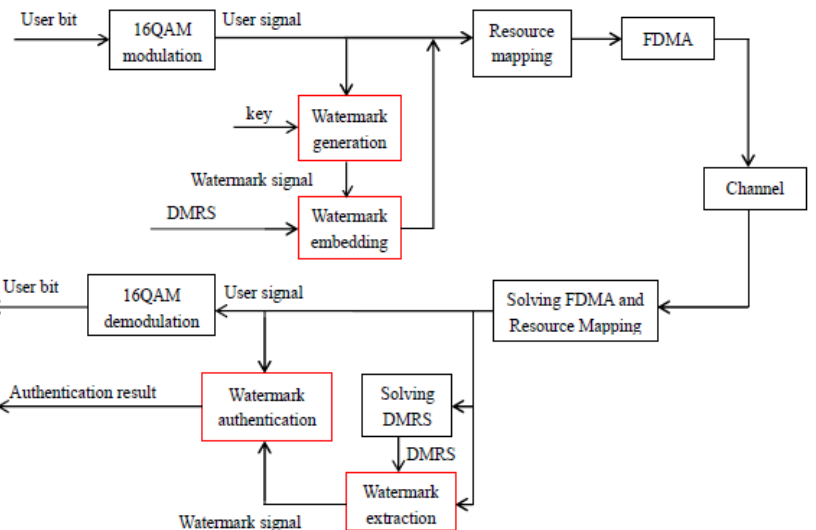
Figure 1. Watermark system model on 5G NR. The black box represents the signal generation process specified by the existing 5G protocol, and the red box represents the embedding and extraction process of the watermarking scheme designed in this paper. In the model, FDMA means frequency division multiple access and DMRS means demodulation reference signal.